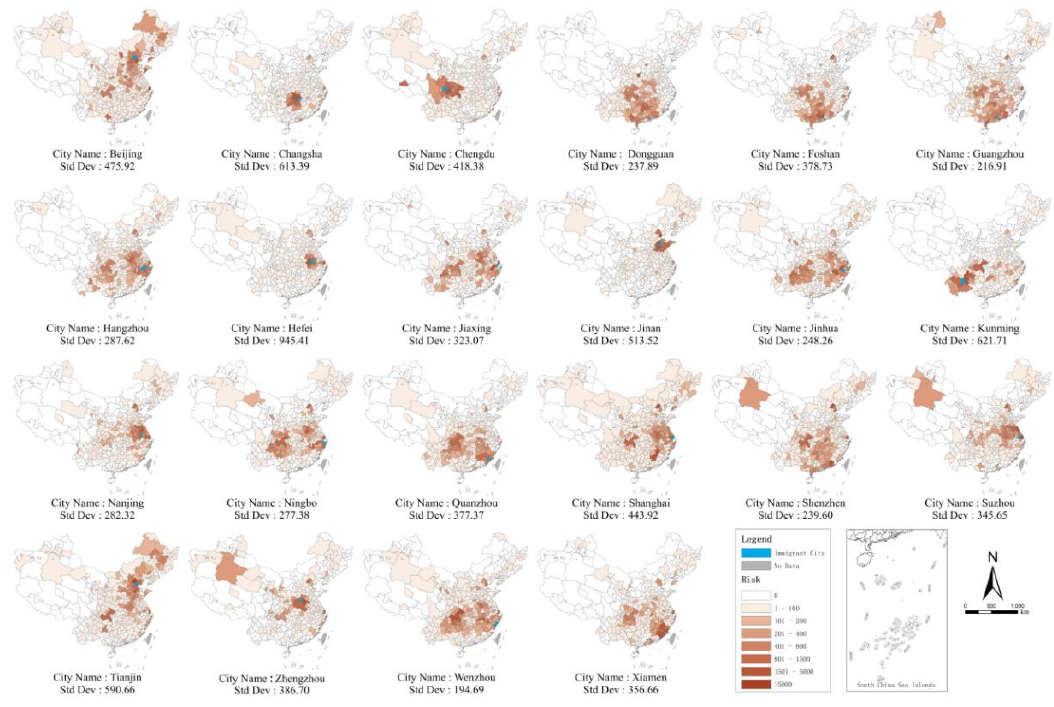
Figure 2. Risk ranking of other prefecture-level cities in the top 22 immigrant cities under a similar emerging epidemic outbreak scenario.